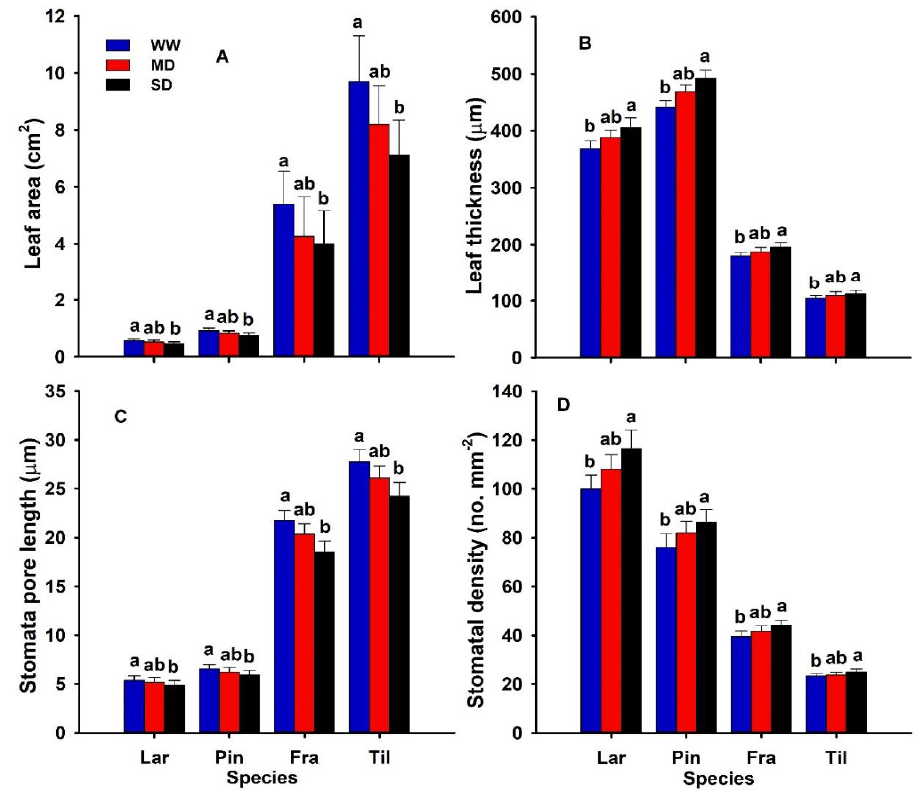
Figure 2. Leaf area (LA; cm 2 ) ( A ), leaf thickness (LT; µm) ( B ), stomatal pore length (SL; µm) ( C ), and